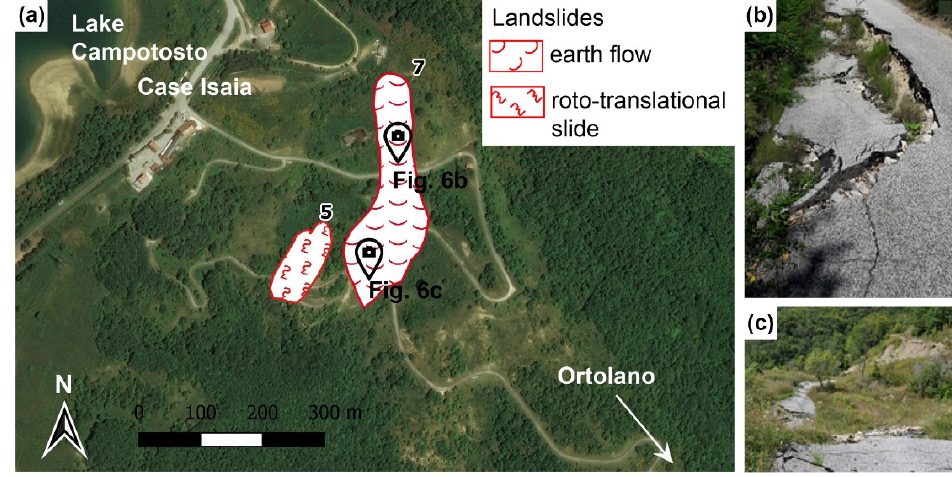
Figure 6. Landslides ID.5 and ID.7: ( a ) satellite view; ( b , c ) photographs of the landslide ID.7 (from [75]).